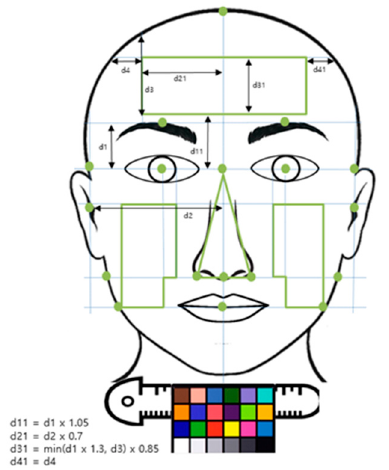
Figure 1. Three regions of facial complexion (forehead, cheek, and nose) [23]. Light green lines and nodes show the grid and facial landmarks used for the construction of facial regions, along with a color chart used for color correction placed below the chin.